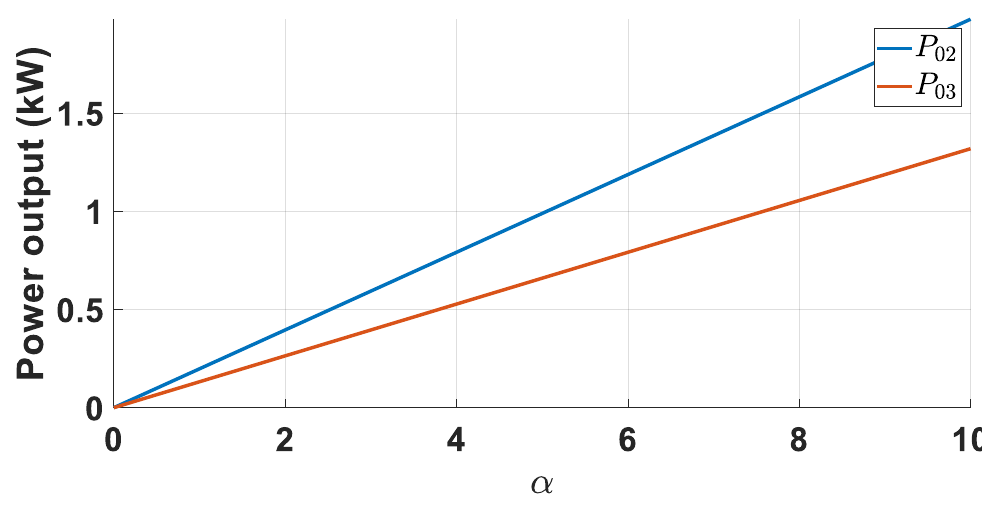
Figure 8. Sensitivity of 𝑃 02 and 𝑃 03 to α .